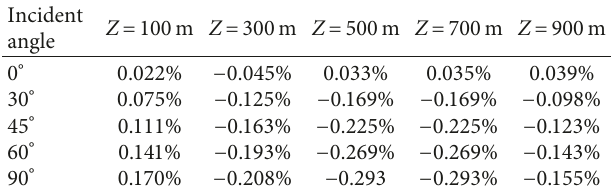
0m, (b) x 500m, and (c) x 1000m. (cid:31) (cid:31) (cid:31) Table 4: Lateral maximum diameter strain rate of tunnel under multisupport seismic motion.